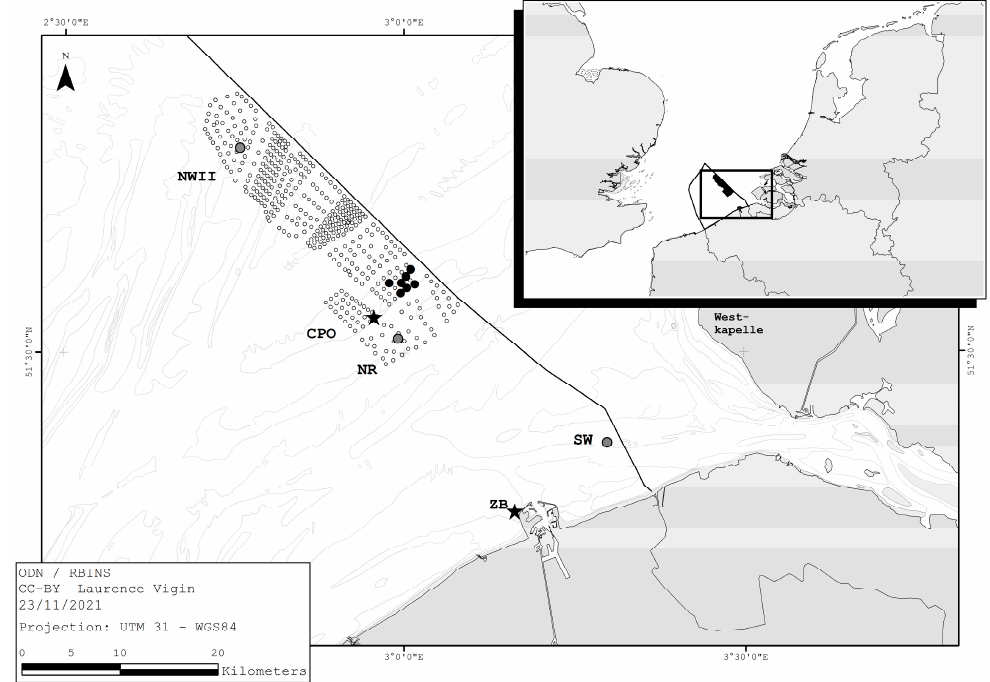
Figure 1. Location of the batcorders during the 2017 and 2020 surveys in the Belgian part of the North Sea. In 2017, seven batcorders were installed on different wind turbines in the in the northeast of the C-Power (CPO) wind farm on the Thorntonbank (black dots). In 2020, three batcorders were installed on the offshore platforms of the Norther (NR) and Northwester II (NWII) wind farms and on the Scheur-Wielingen (SW) platform (grey dots). Meteorological data were collected at the C-Power offshore transformation station (star), Scheur-Wielingen, and Zeebrugge (ZB) port meteopark (star). Wind turbines are shown as small